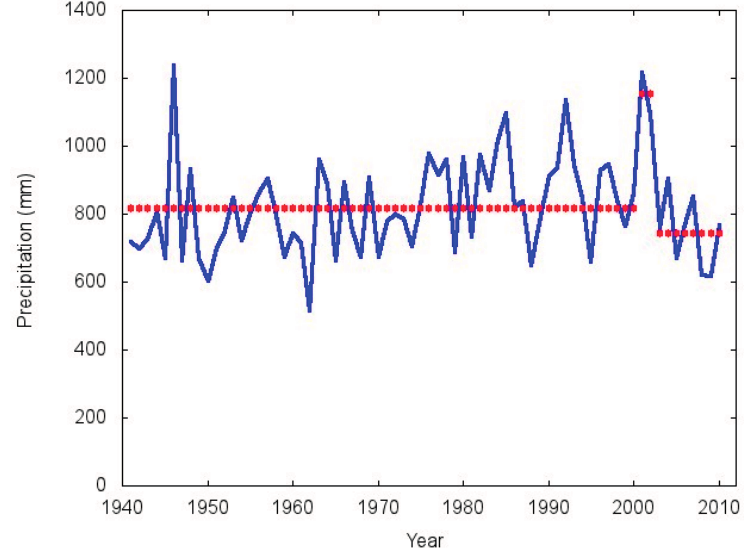
Figure 9. Annual precipitation and means for the sub-periods in the Southern Pampa sub region by Hubert’s segmentation